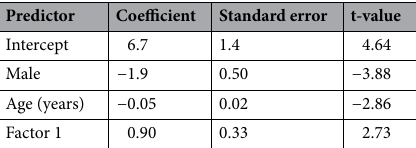
Table 4. Results in the final regression model with 210 Po as response